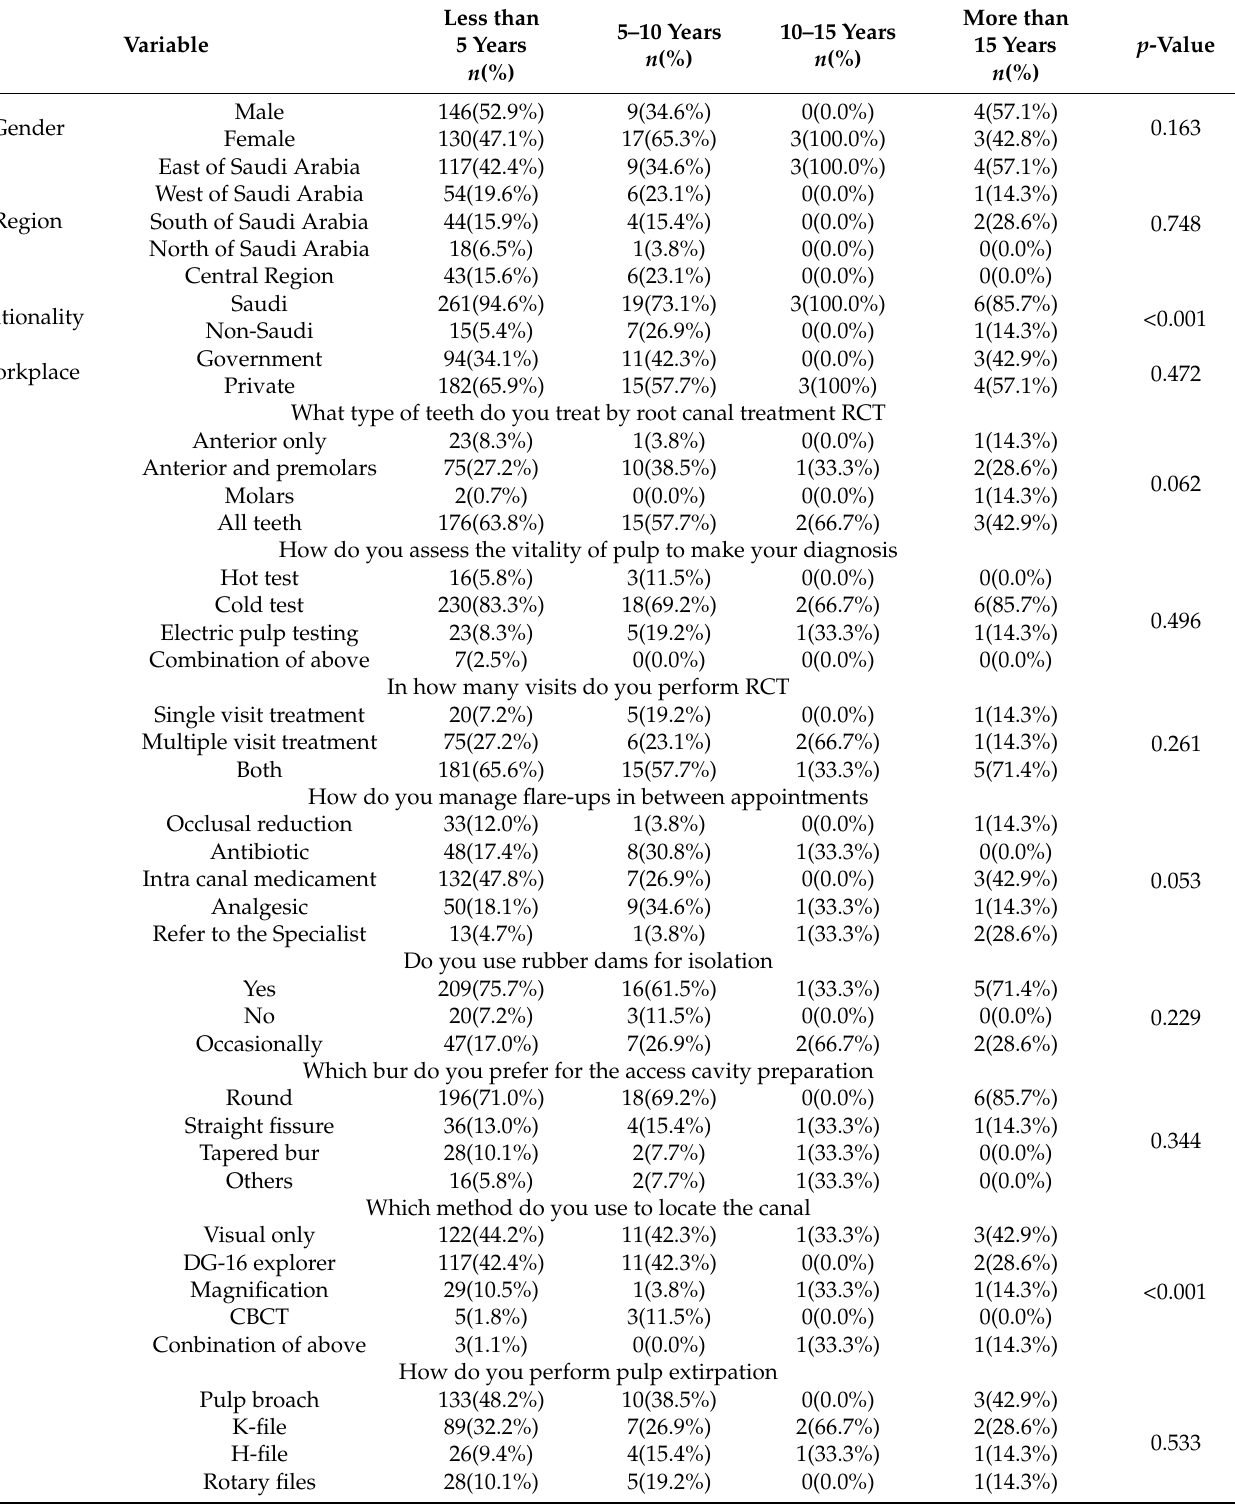
Table 4. Association of demographic profile and endodontic practices with respect to years of professional